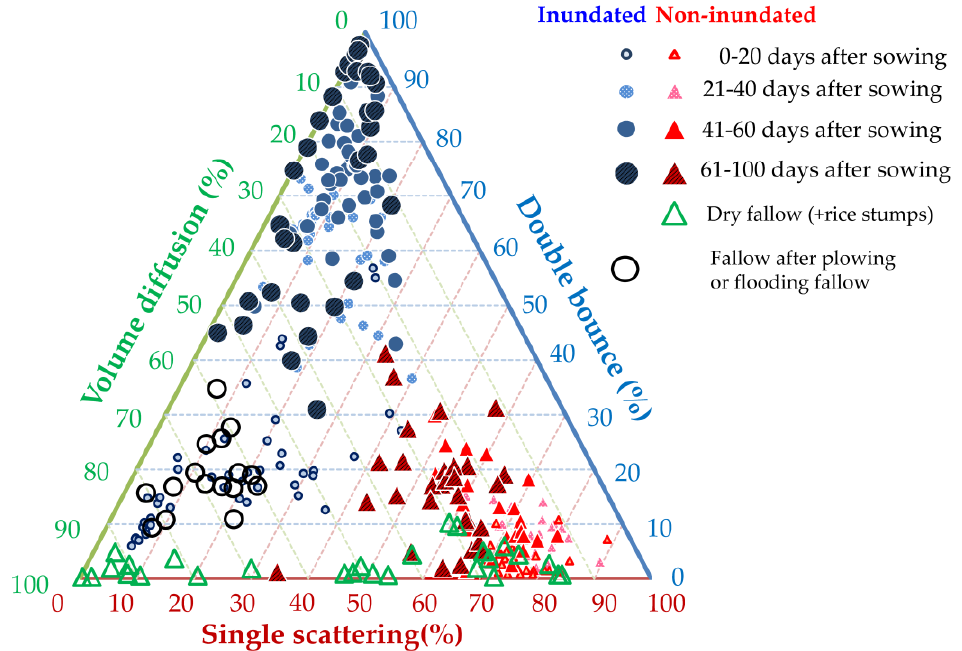
Figure 7. Ternary plot of the intensity of three components (single scattering, volume diffusion, and double bounce) produced by the Freeman – Durden decomposition. The lightest/smallest closed blue circles (n = 48) indicate the mean value among 25 – 30 pixels of an inundated paddy ROI (up to 20 days after sowing). The second lightest/smallest dotted blue circles (n = 30) represent 21 – 40 days after sowing. The third lightest/smallest closed blue circles (n = 40) represent 41 – 60 days after sowing. The darkest hatched blue circles (n = 32) represent 61 – 100 days after sowing. The black open circles (n = 16) represent the fallow period just after plowing or an inundated fallow period. The smallest red open triangles (n = 36) indicate the mean value among 25 – 30 pixels of a noninundated paddy ROI (0 – 20 days after sowing). The second lightest/smallest dotted red triangles (n = 28) indicate 21 – 40 days after sowing. The third lightest/smallest closed red triangles (n = 26) indicate 41 – 60 days after sowing. The darkest hatched red triangles (n = 33) indicate 61 – 100 days after sowing. The open green triangles (n = 27) indicate dry soil and rice stumps during the fallow seasons.